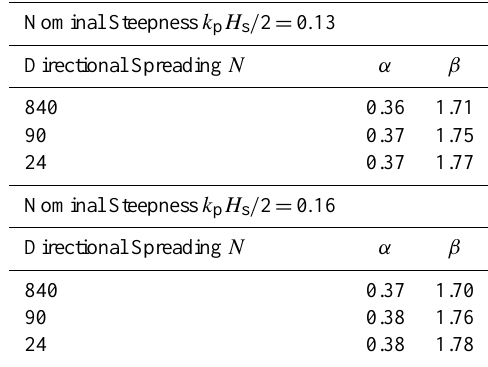
Table 1. Fitted Weibull